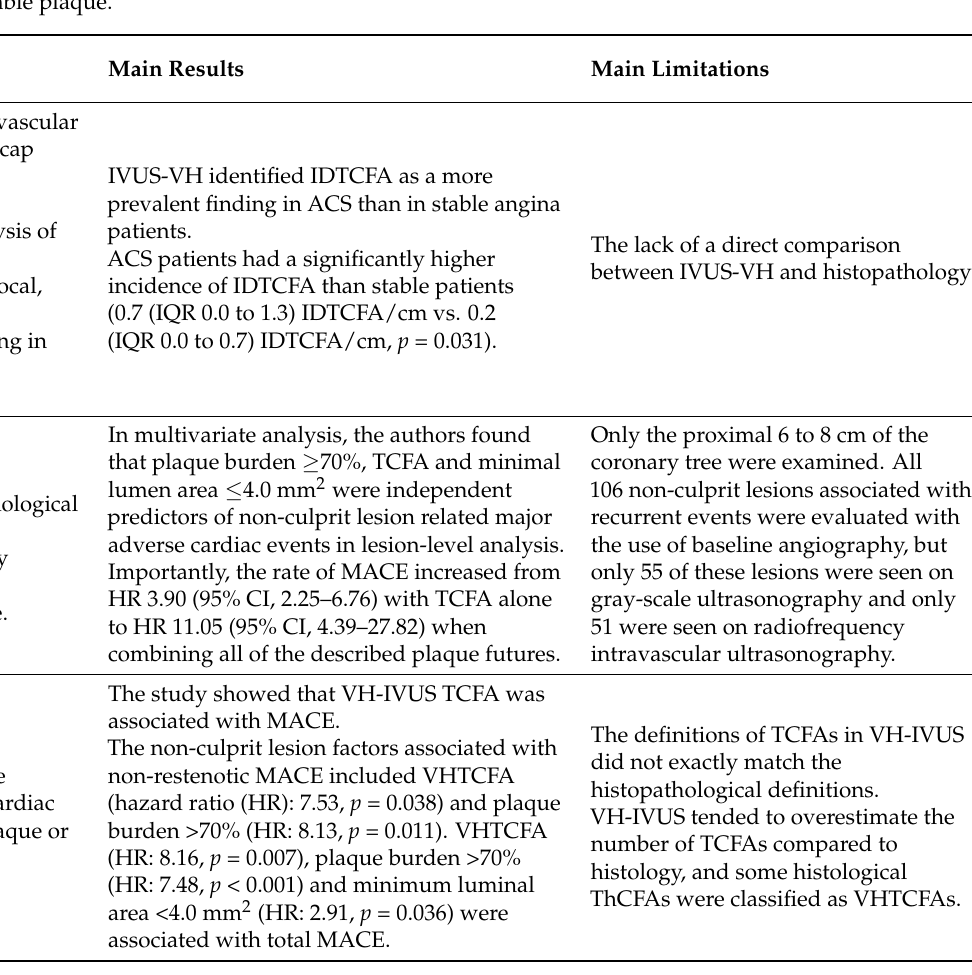
Table 1. Summary of studies assessing components of vulnerable